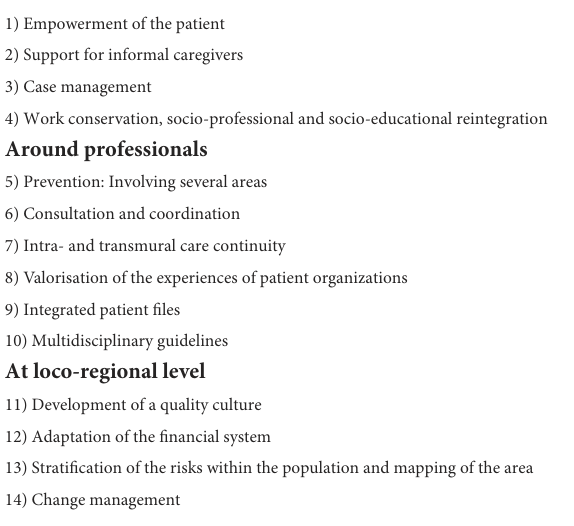
TABLE 1 Fourteen components of integrated care framing the 12 ICPs work. Around the